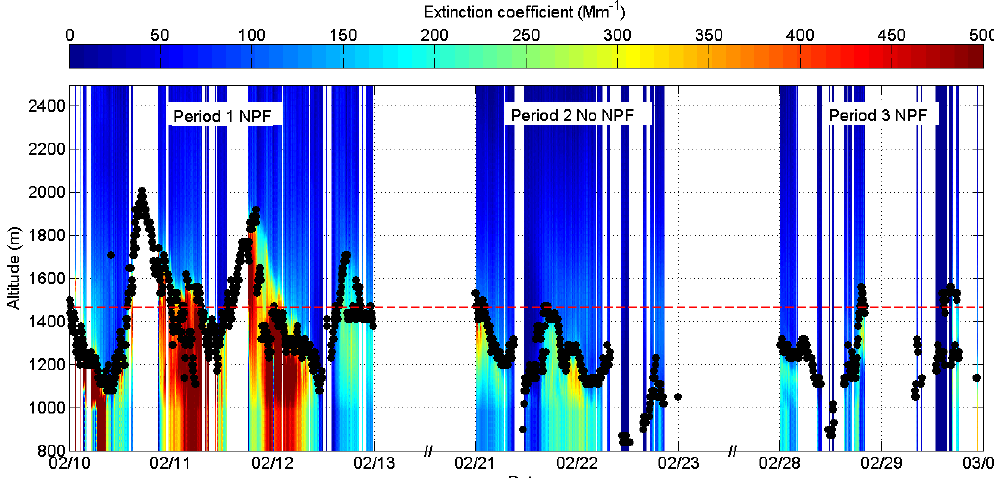
Figure 1. Boundary layer height determination from LIDAR measurements. In the present study, boundary layer (BL) height (black dots) is assumed to be equal to the aerosol mixing layer height and was calculated using the WCT method. Red dashed line represents the altitude of the station (1465ma.s.l). The presence of high-altitude clouds or frost on the instrument avoids both the extinction coefficient and the BL height calculations. However, when clouds are detected at the altitude of the station, the values of the extinction calculation remain unreliable but a correct estimation of the BL height is allowed. The occurrence of NPF during the sub-periods defined in Sect. 3.1 is indicated at the top of the figure. February 2012, Puy de Dôme. Table 1. Cluster concentrations for each sub-period. Median, 25th and 75th percentiles of charged cluster concentration ( N i ) , total cluster concentration ( N tot ) and neutral cluster concentration ( N n ) during the different periods. The indices day refer to values calculated over the whole day whereas the indices nucl refer to values calculated during the time period 10:30–14:00 (UTC). Indication <LDL refers to con- centrations below the lower detection limit (500cm − 3 ) that was set for the total cluster concentration measured by the PSM; corresponding neutral cluster concentrations which are negative are not reported. The occurrence of NPF during the sub-periods is shown in the table. February 2012, Puy de Dôme. Period 1 NPF Period 2 No NPF Period 3 NPF Med. 25th perc. 75th perc. Med. 25th perc. 75th perc. 75th perc